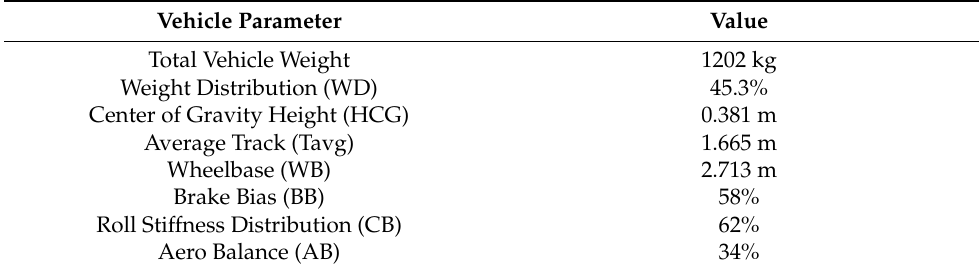
Figure 2. Nürburgring GP track layout used for the simulations. Table 1. Relevant vehicle parameters used for the